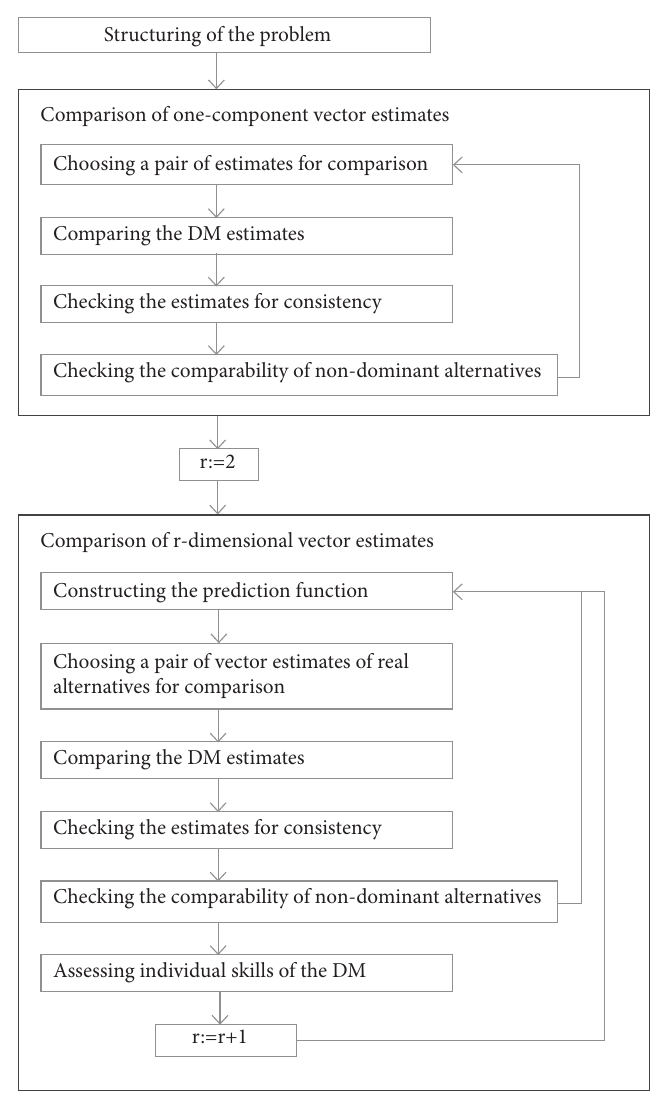
Fig. 1. A diagram of the procedure for eliciting the DM